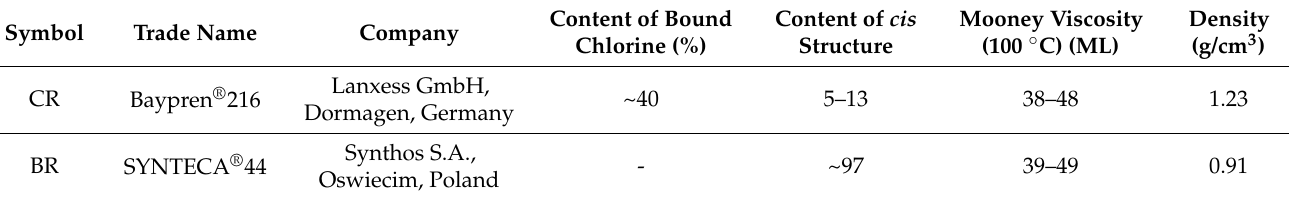
Table 1. The characteristics of the rubbers.